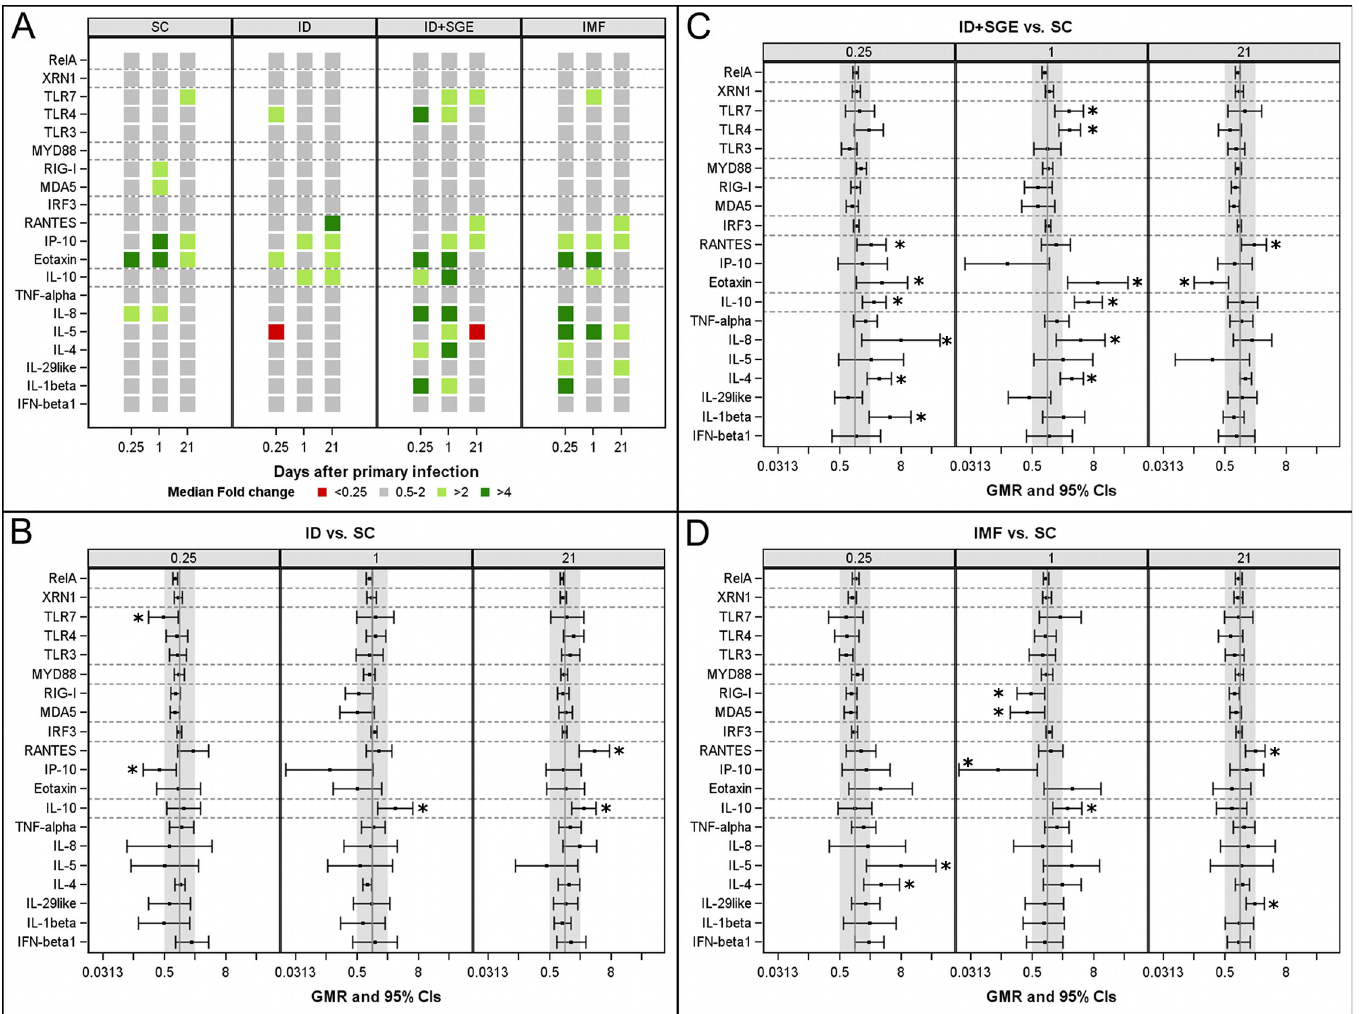
Fig 3. Transcriptional analysis following primary DENV-1 infection in administration sites of skin. Skin biopsies from DENV-1 administration sites were collected immediately prior to administration (0h), and at 6 hours, 24 hours, and 21 days later. A) Heat map of median fold changes from baseline (0h) by group and time point for each gene. B), C), and D) display geometric mean ratios with 95% confidence intervals of ID, ID+SGE, and IMF groups, respectively, relative to the SC group. Vertical grey bands indicate the 2-fold cutoff region on either side of 1 (no change). Analyses of transcriptional data were based on fold change from baseline derived from the ΔΔ Ct method. To compare each group to the SC group, an ANOVA model was fitted on log 2 fold changes by including group, time, and group � time as fixed effects. Time was considered as a repeated factor with an unstructured matrix and heterogeneous variances between groups were assumed. Geometric means and geometric mean ratios and their respective 95% CIs were derived from this model. No adjustment for multiplicity was performed. n = 10 for each SC, ID+SGE, and IMF; n = 9 for ID. ( � , p < 0.05). SC, subcutaneous; ID, intradermal; ID+SGE, intradermal + salivary gland extract; IMF, infectious mosquito